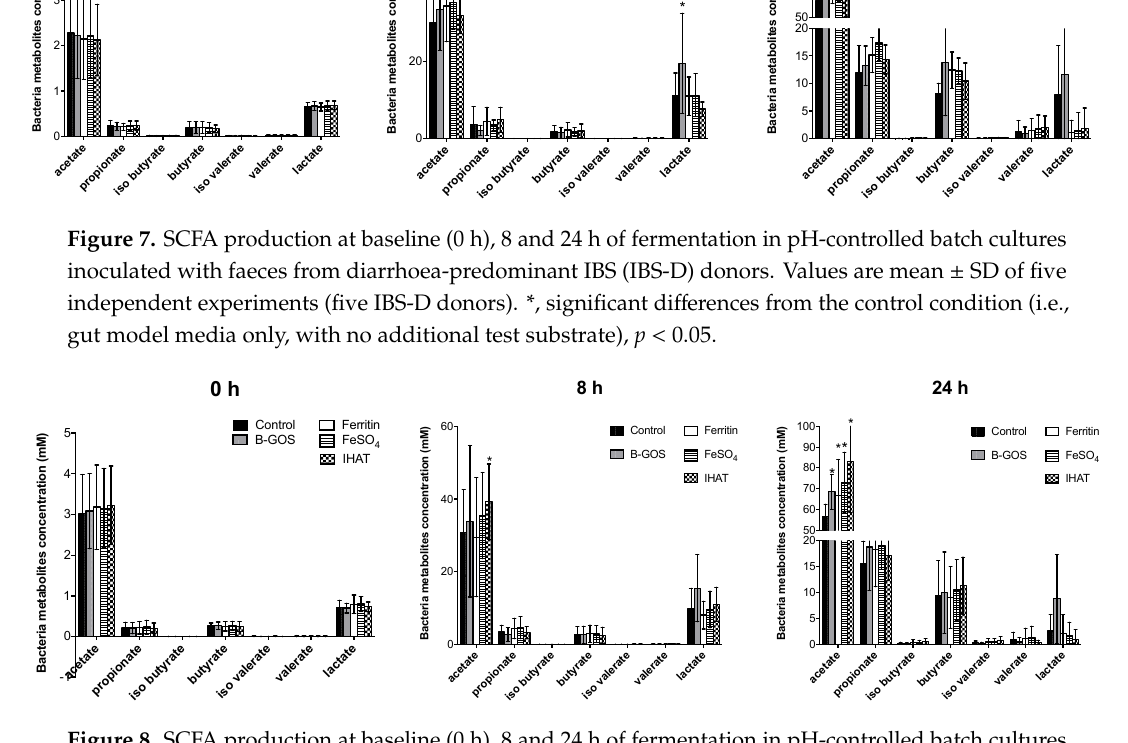
Figure 8. SCFA production at baseline (0 h), 8 and 24 h of fermentation in pH-controlled batch cultures inoculated with faeces from constipation-predominant IBS (IBS-C) donors. Values are mean ± SD of five independent experiments (five IBS-C donors). *, significant differences from the control condition (i.e., gut model media only, with no additional test substrate), p < 0.05.